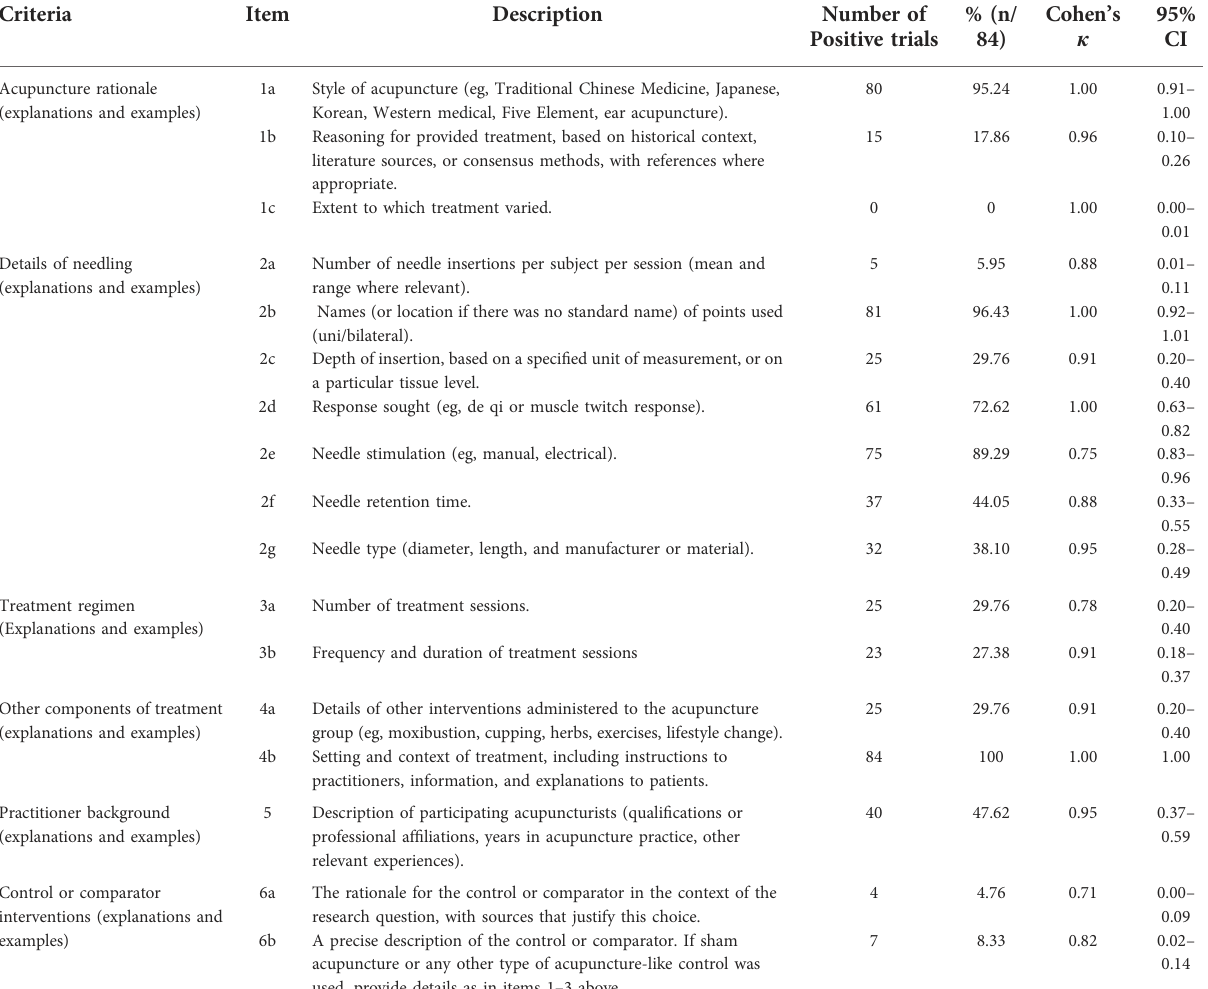
TABLE 2 Assessment of reporting quality of needling details from STRICTA ( n =84